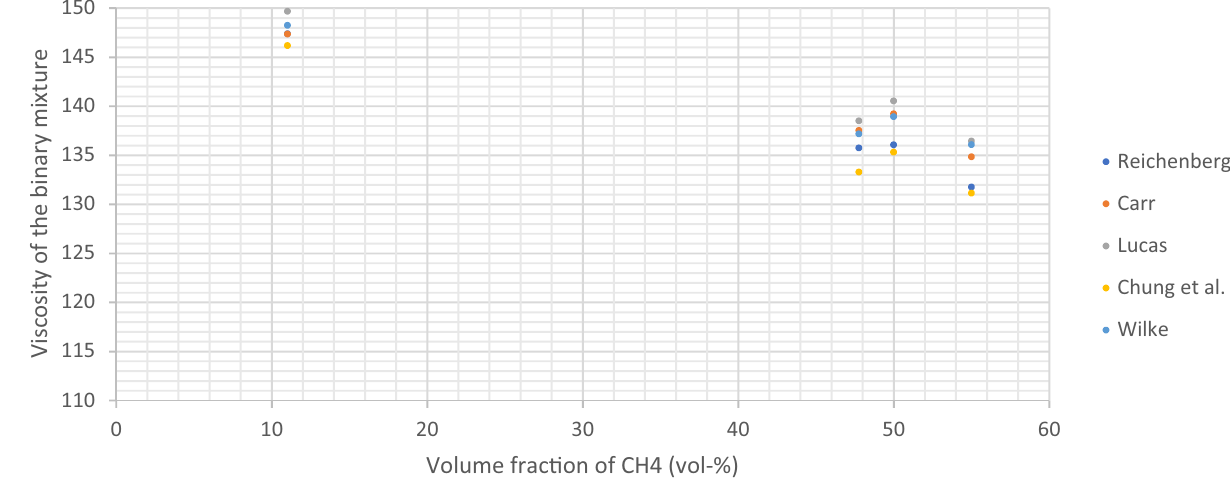
Figure 3. Viscosity of the multi-components gas mixtures from Table 2 calculated using five different